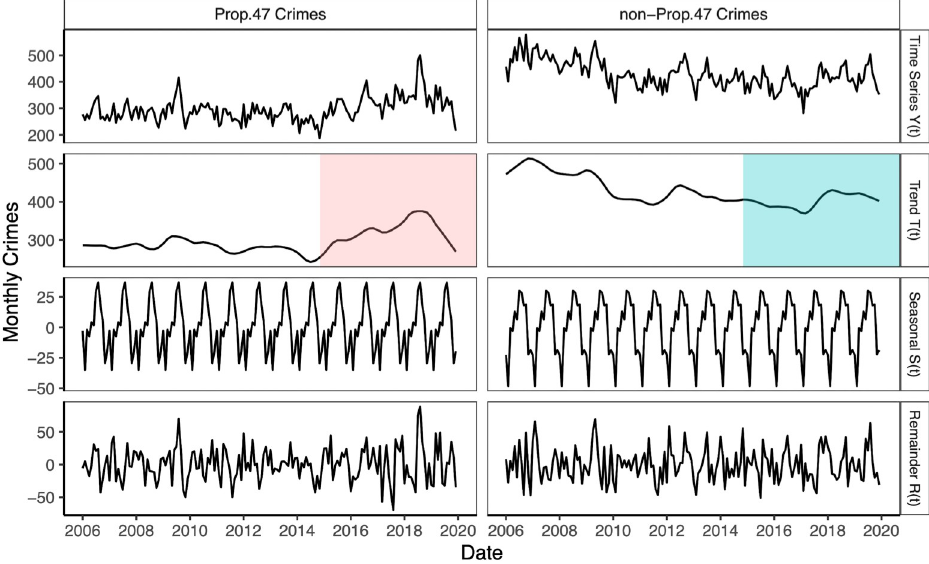
Fig 5. Additive Seasonal and Trend decomposition using Loess (STL) for reported monthly crimes in Santa Monica, CA, 2006–2019. The time series of reported crimes per month Y ( t ) is separated into trend T ( t ), seasonality S ( t ), and remainder R ( t ) components. We perform this decomposition for Prop. 47 crimes (left) and non-Prop. 47 crimes (right). The colored regions in the plot of the trend T ( t ) indicate the time period following the enactment of Prop. 47. An increase in the trend emerges for the Prop. 47 crimes towards the end of 2014, but not for non-Prop. 47 crimes. For these results, the STL smoothing window is w trend = 19.